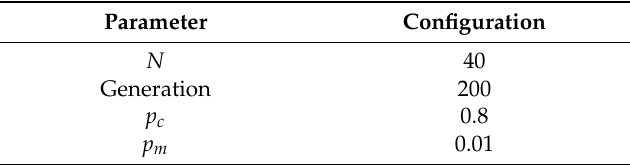
Table 1. The Parameters Configurations of